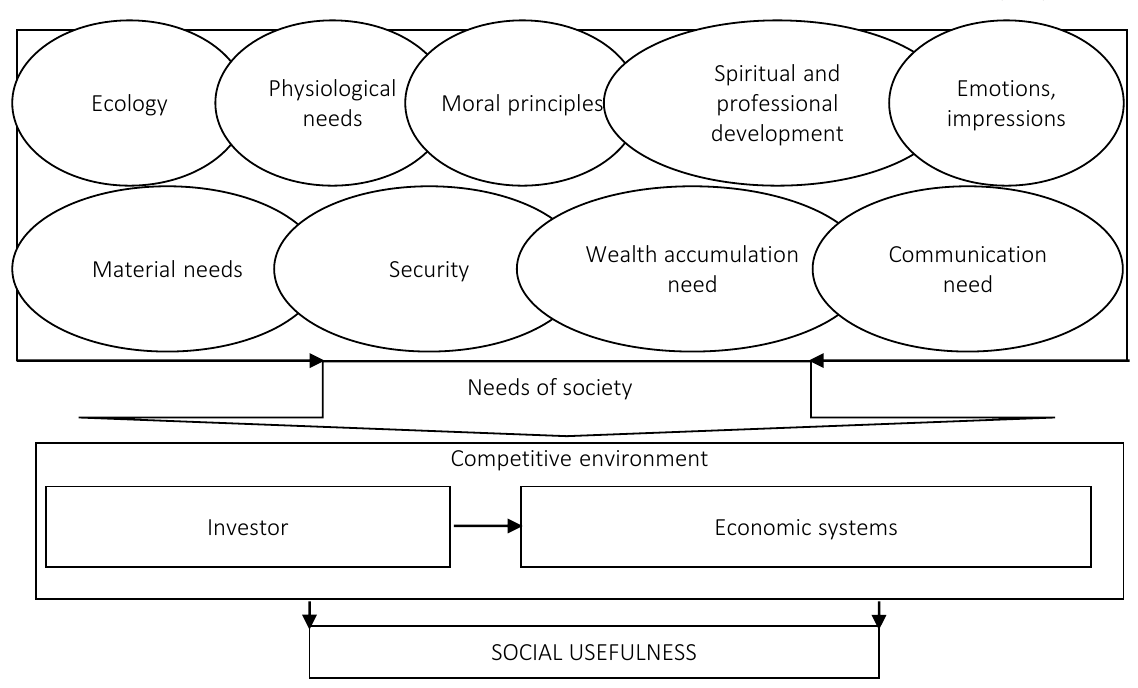
Figure 1. Sphere of interaction of investments and social environment